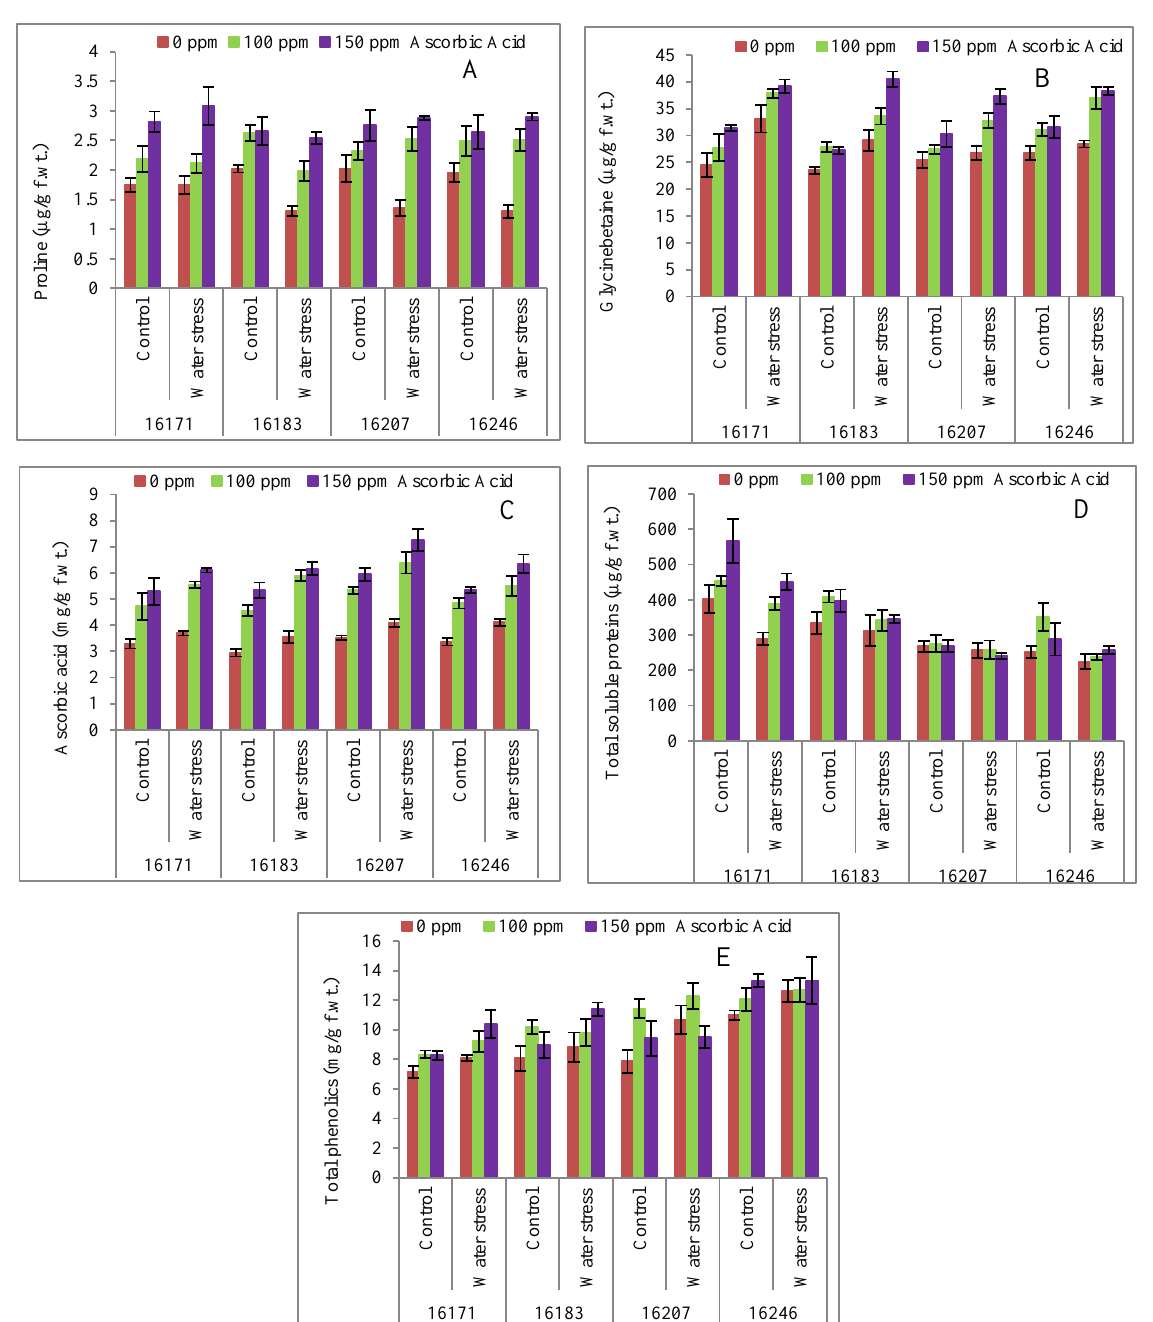
Figure 3. Proline ( A ), glycine betaine ( B ), ascorbic acid ( C ), total soluble proteins ( D ), total phenolic ( E ) contents of four cultivars of safflower ( Carthamus tinctorius L.) foliarly treated with ascorbic acid subjected to water stress conditions (mean ± S.E.).